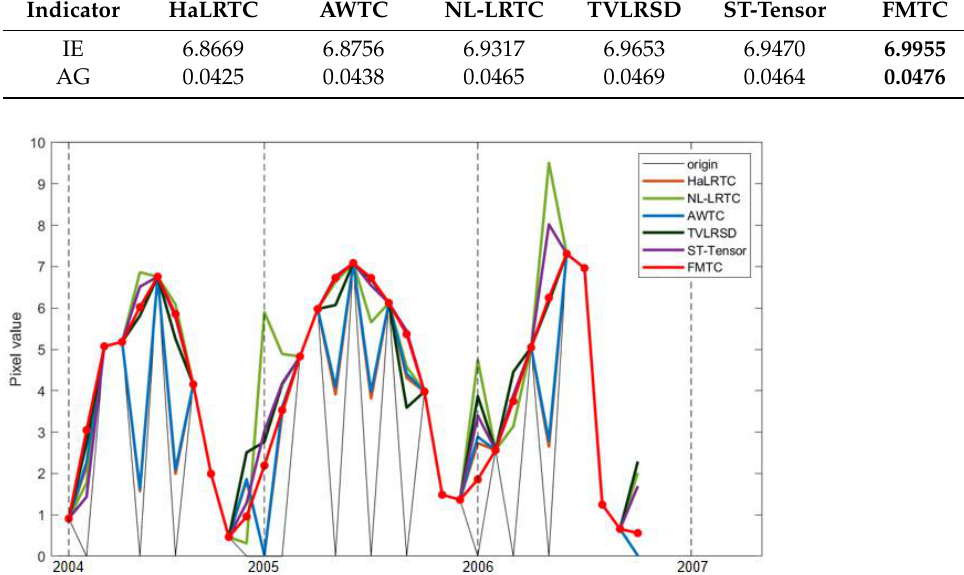
Table 6. Quantitative comparison of six algorithms applied to dataset 6.